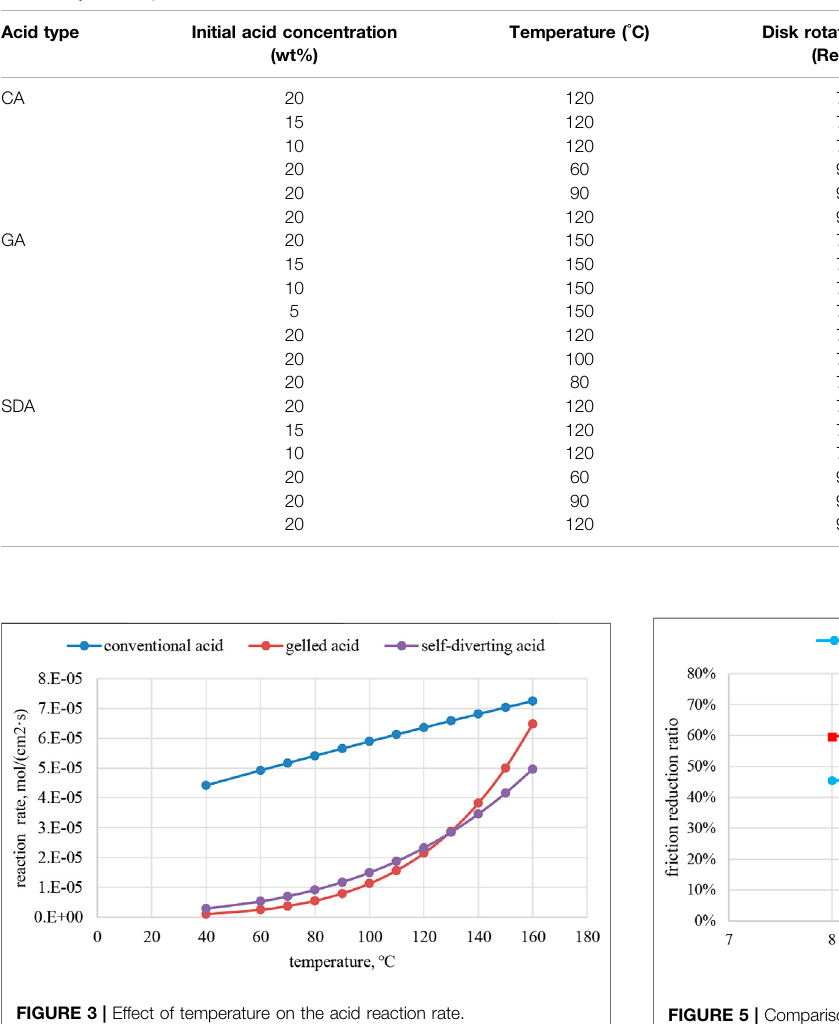
FIGURE 5 | Comparison of friction reduction for gelled and self- diverting